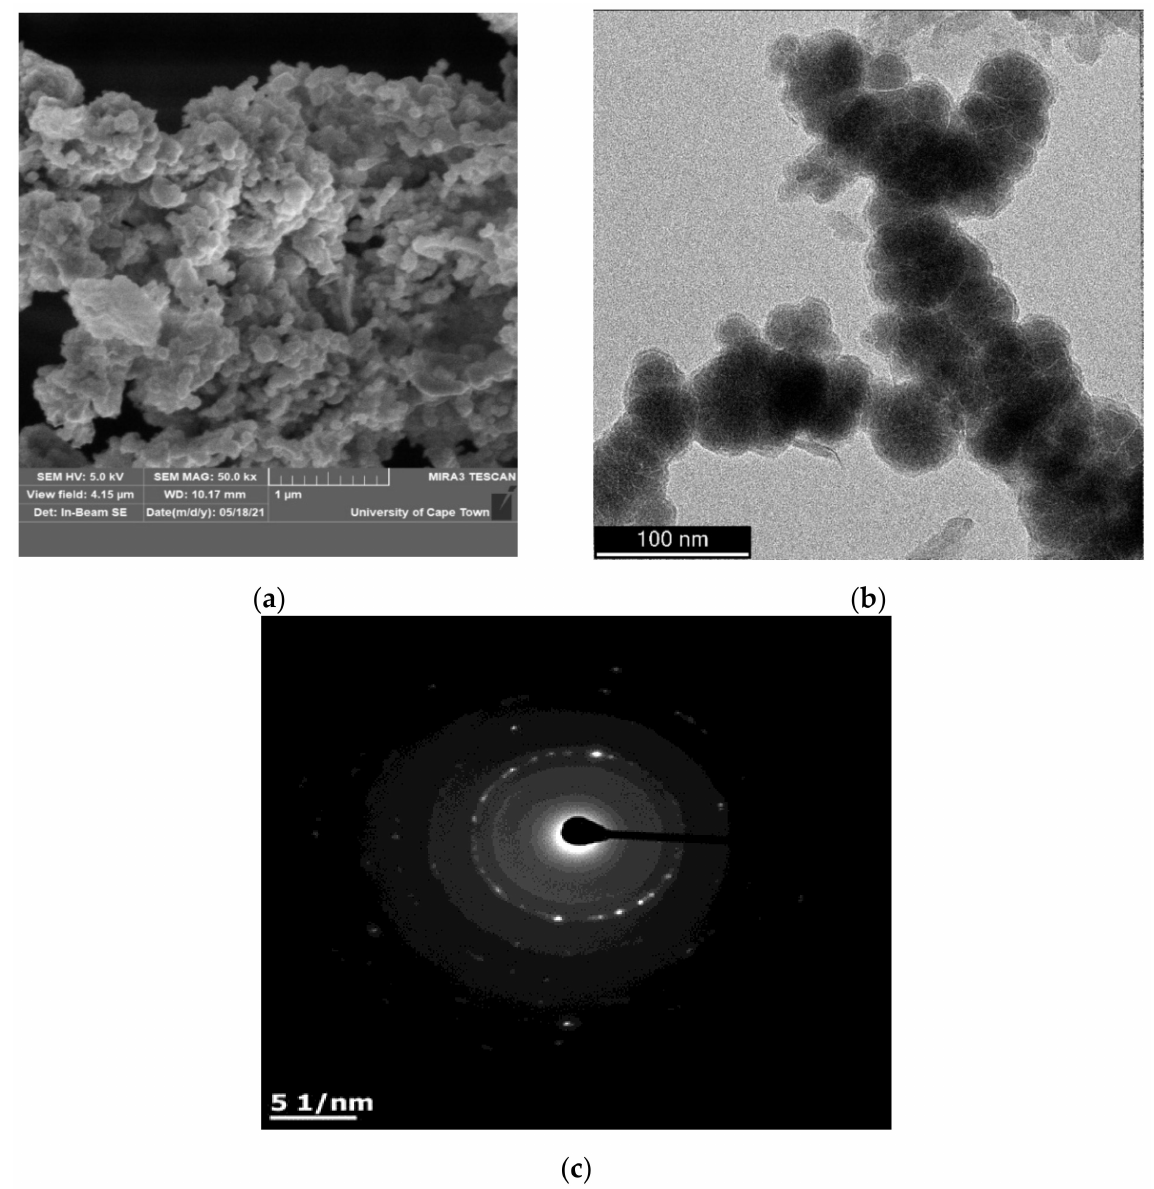
Figure 2. SEM ( a ), TEM ( b ), and SAED ( c ) of iron oxide